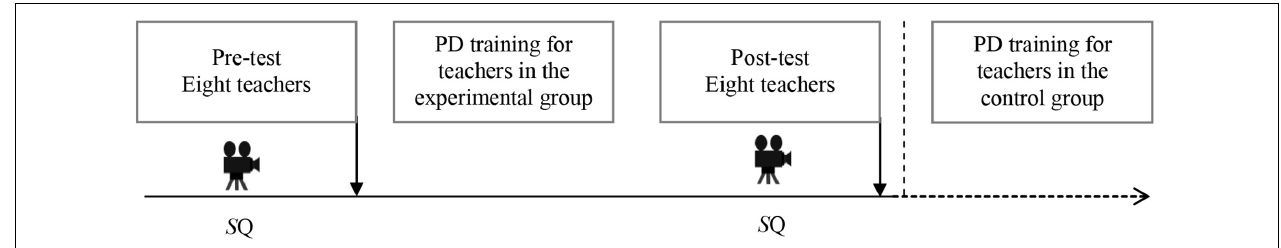
FIGURE 2 | General research design showing data collection events. Video icon = Videotaped lesson of plenary feedback discussions; SQ = Student Questionnaire, PD = Professional